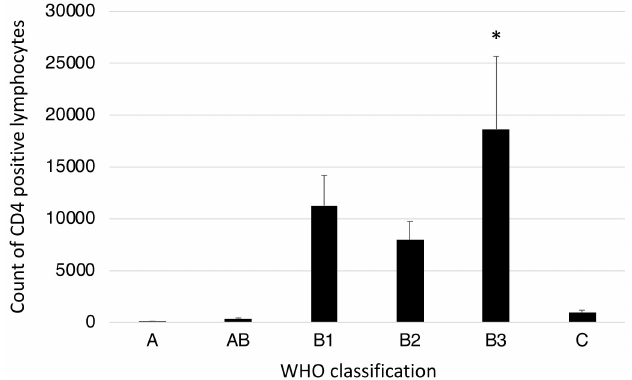
Figure 6. Comparison of CD4 + lymphocyte counts according to the WHO classification of TETs. * p < 0.05 compared to type A, AB, and C